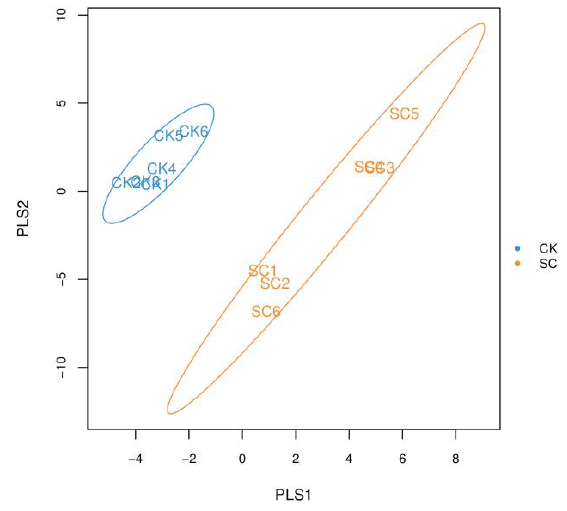
Figure 3. Principal component analysis of the nifH gene fragments of diazotroph at the OTU level. Abbreviations: SC, grasslands invaded by S. chamaejasme ; CK, uninvaded grasslands.